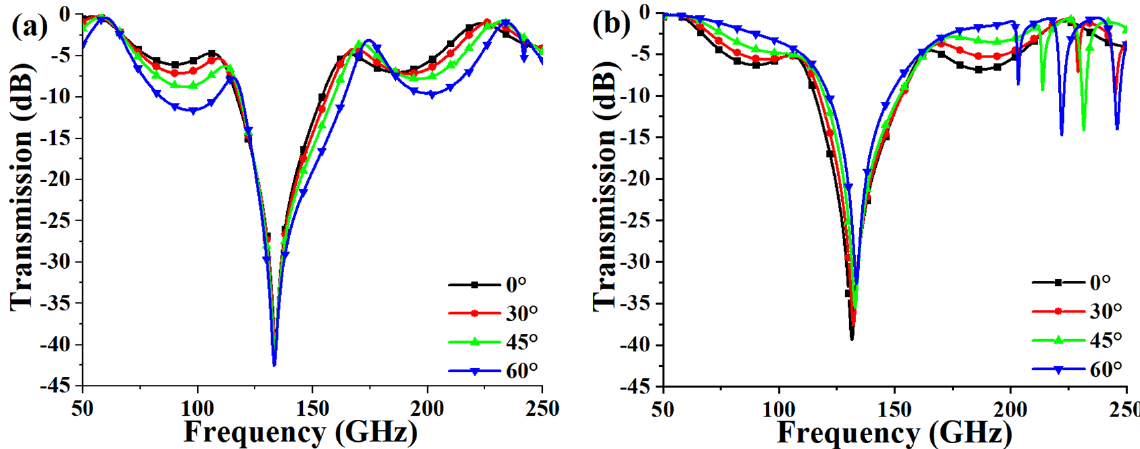
Figure 5. Transmission response under different incident angles for ( a ) TE polarization and ( b ) TM polarization.